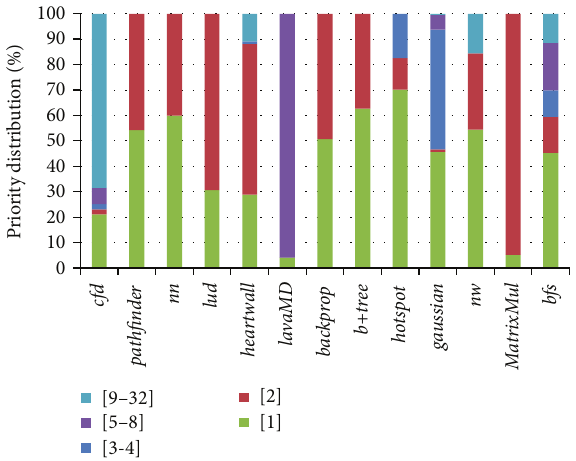
Figure 6: Priority distribution of GPU memory